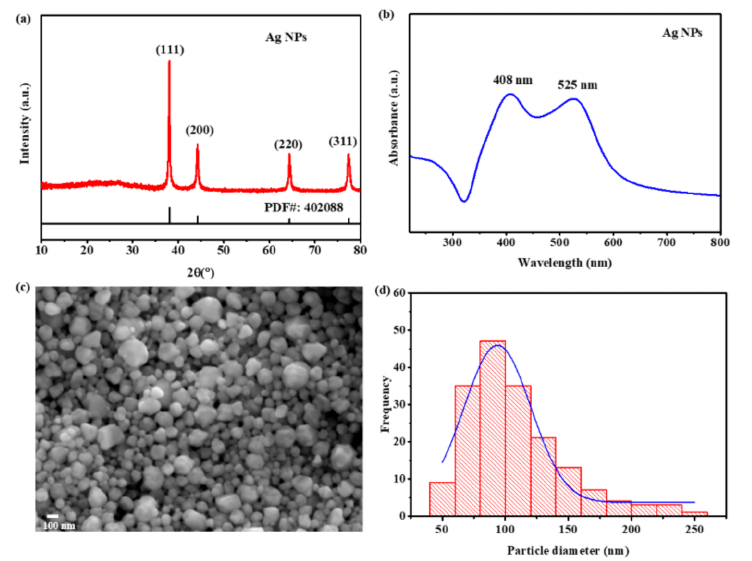
Figure 2. ( a ) XRD pattern; ( b ) UV-Vis spectrum; ( c ) SEM image of the synthesized Ag NPs; ( d ) particle size distribution histogram determined from the SEM